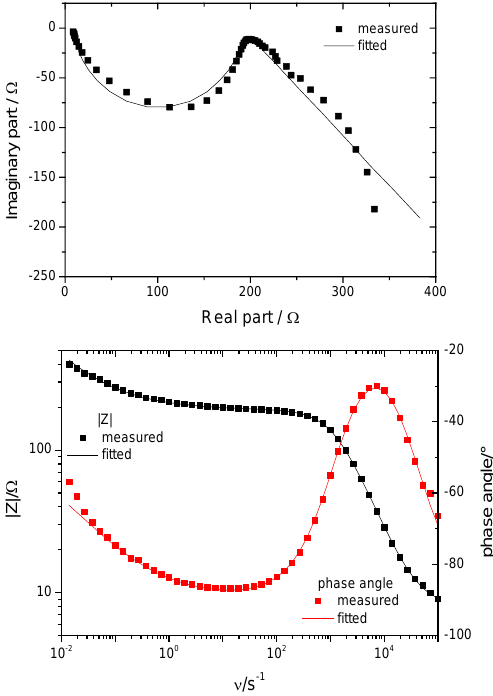
Figure 3. Nyquist and Bode plots of the platinum disc electrode (with 9.9 mC platinum deposit) in contact with an aqueous electrolyte solution of 0.1 M (NH 4 ) 2 Fe(SO 4 ) 2 + 0.1 M (NH 4 )Fe(SO 4 ) 2 + 1 M HClO 4 . Changes in the C DL (taken from CVs with a supporting electrolyte solution only) and